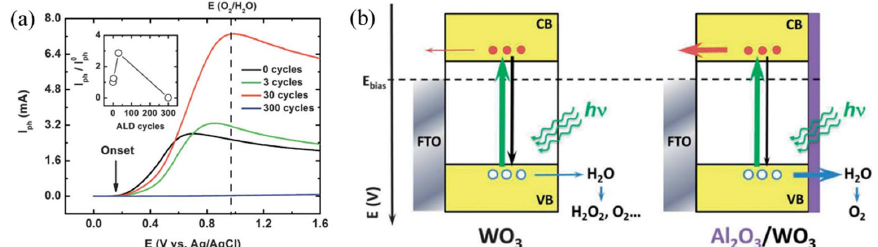
Figure 3. ( a ) Voltammetric response of transparent Al 2 O 3 /WO 3 electrodes under simulated AM 1.5 G illumination (120 mW cm − 2 ). The alumina overlayer was deposited by ALD for 0 cycles (black), 3 cycles (green), 30 cycles (red) and 300 cycles (blue). Electrolyte: Ar ‐ purged 0.1 M HClO 4 (pH 1.0). Scan rate: 20 mV s − 1 . The photocurrent (I ph ) was obtained by correcting the capacitive contribution in the dark. Inset: normalized photocurrent values taken at 0.97 V (vs. Ag/AgCl) (thermodynamic potential of water oxidation at pH 1.0) as a function of ALD cycles. ( b ) Schematic illustration of hole ‐ and electron ‐ mediated charge transfer occurring on WO 3 (left) and Al 2 O 3 /WO 3 (right) illuminated electrodes biased at a potential around the thermodynamic water oxidation potential (0.97 V vs. Ag/AgCl). The purple rectangle on the right side represents the alumina overlayer. For the sake of clarity, electrons (red, full circles) and holes (blue, open circles) are represented as free on the con ‐ duction (CB) and valence (VB) bands, respectively. Likewise, blue and red arrows represent hole and electron ‐ mediated processes, respectively. Green arrows represent the photogeneration of elec ‐ tron–hole pairs. Black arrows represent recombination losses. Relative arrow thicknesses represent the rate of the processes (the thicker the arrow, the faster and more effective the process). Repro ‐ duced from [39] with permission.